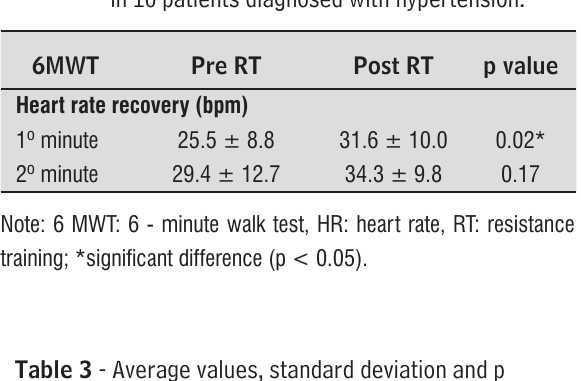
Table 2 - Average values, standard deviation and p val- ue of HRR in the 6-minute walk test, developed in 10 patients diagnosed with hypertension.